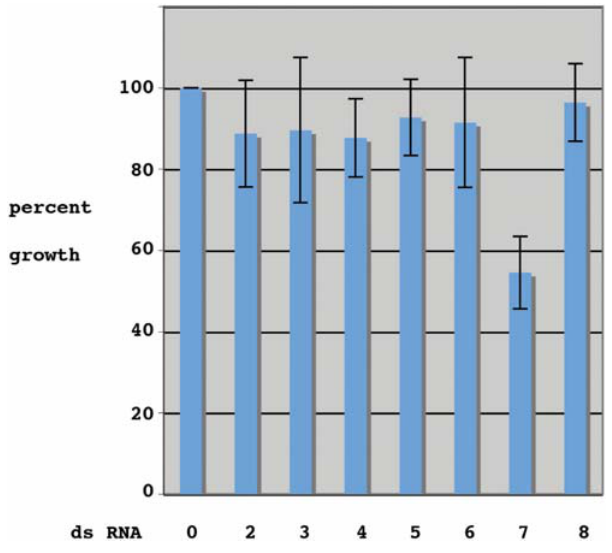
Figure 4. Day 5 growth profiles of MCM targeted cells compared to a control cell line. The data presented shows combined data from seven independent experiments. The data is expressed as a percentage of the control. Lane 1 is the control and lanes 2-8 are MCM 2-8 resepectively.